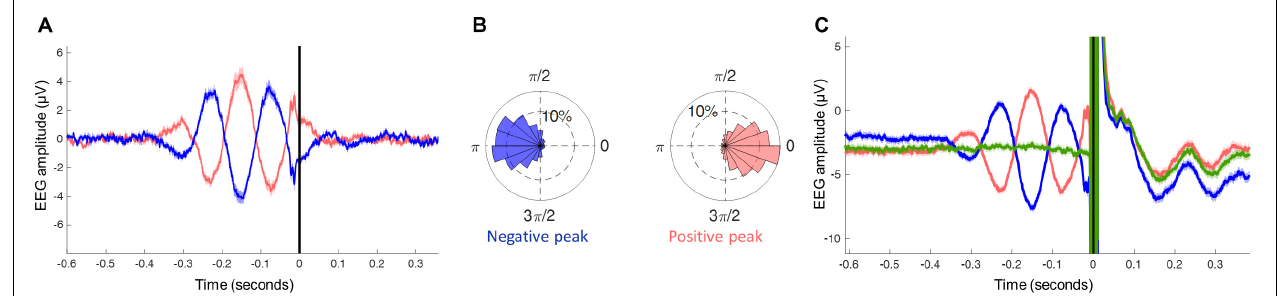
FIGURE 4 | (A) EEG signal generated by the individual filter W ind , averaged across all subjects and trials around the trigger (time 0 s) located by the phase detection algorithm in the non-stimulated trials (red: positive peak; blue: negative peak). (B) Phase histogram of the estimated phases of the oscillation in the theta band at the time of the trigger, divided by trials triggered on the negative peak and positive peak (phase-bin width 20 ◦ , inner ring corresponds to 10% of the total trials). (C) EEG signal generated by the individual filter W ind , averaged across all subjects and trials around the trigger (time 0 s) located by the phase detection algorithm in the stimulated trials (red: positive peak; blue: negative peak; green: random phase). Note the large TMS artifact and TMS-evoked EEG